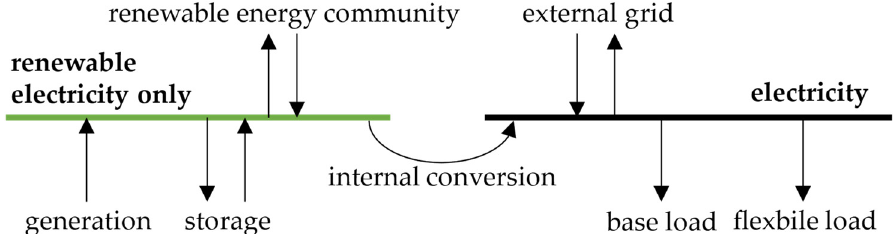
Figure 2. Participant’s energy system model, consisting of categories for renewable electricity only and electricity, the four participant asset types (generation, storage, base load, and flexible load), and the connection points to the external grid and to the renewable energy community.